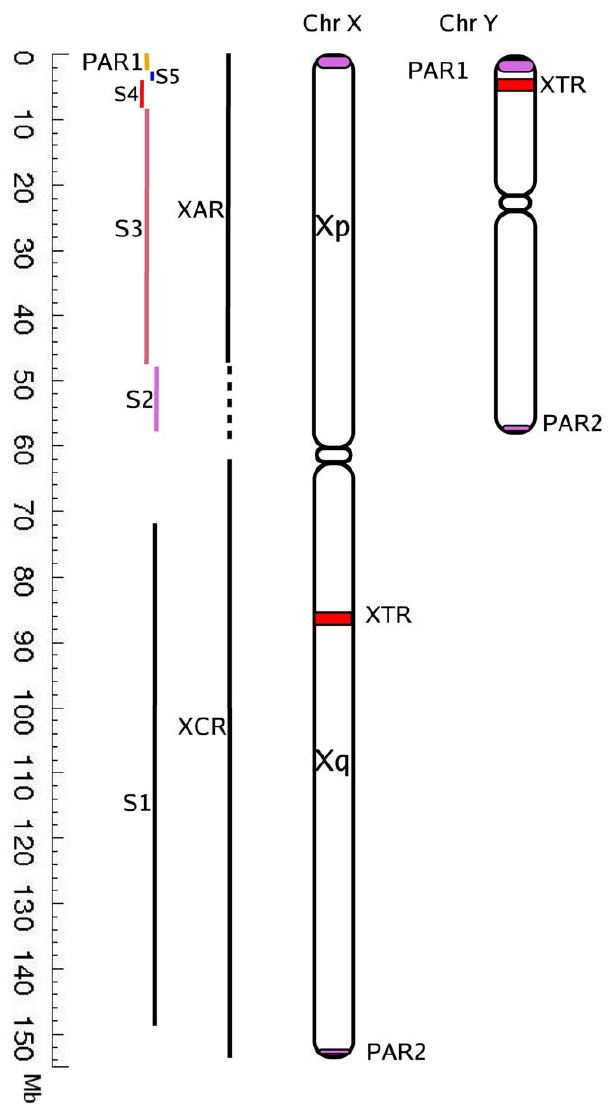
Figure 1. Schematic representation of human sex chromo- somes. The evolutionary strata (S1–S5) as well as the conserved and acquired regions on the X-chromosome (XAR and XCR) are shown by vertical lines parallel to the chromosome. PAR1 and PAR2 are pseudoautosomal regions at both termini of the sex chromosomes and XTR is the X-transposed region. Chromosome Y has a homologous region to PAR1 on the X chromosome.